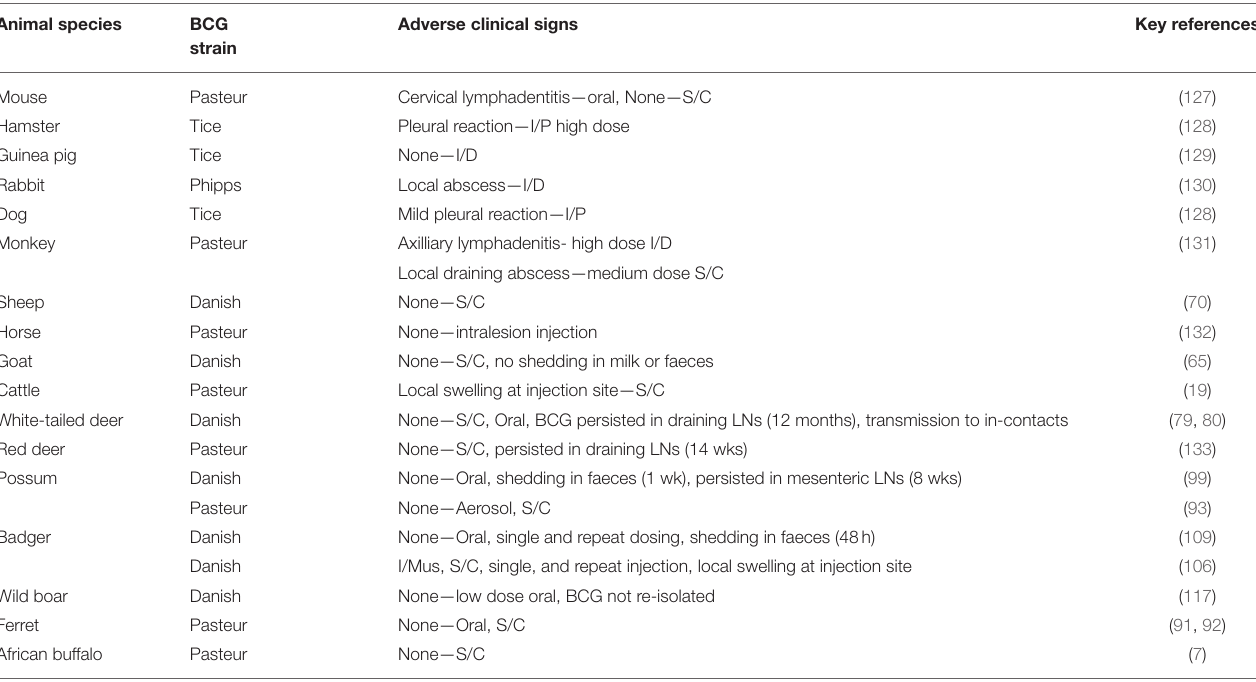
TABLE 4 | Studies of safety of BCG vaccine of different strains in target and non-target animal species. Animal species BCG Adverse clinical strain